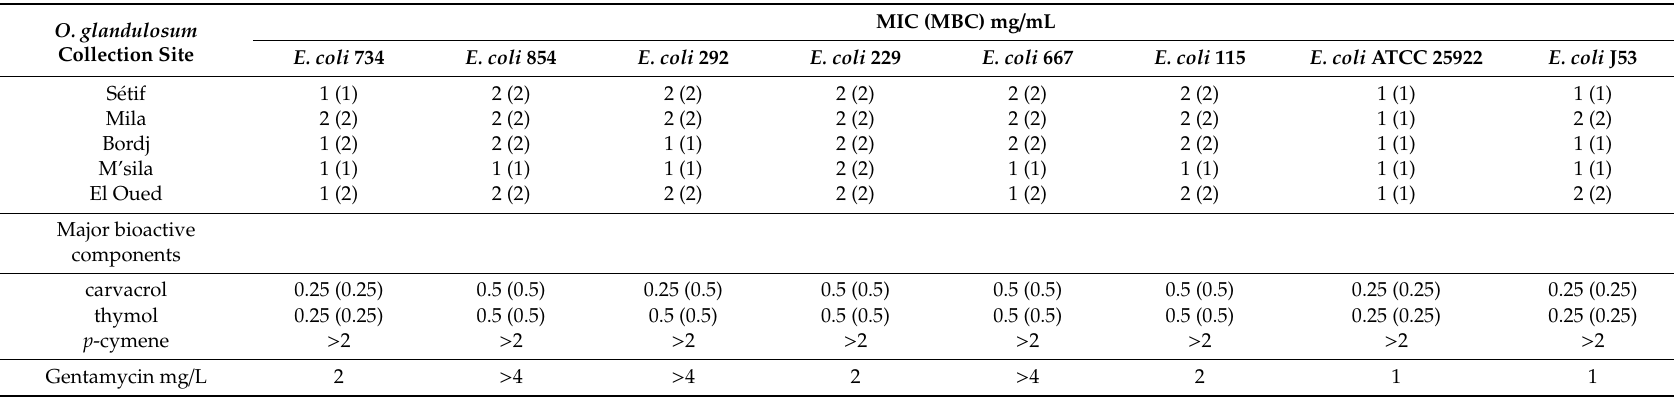
Table 3. Minimum inhibitory concentration (MIC) and minimum bactericidal concentration (MBC) of O. glandulosum EOs and main active pure compounds. O. glandulosum Collection